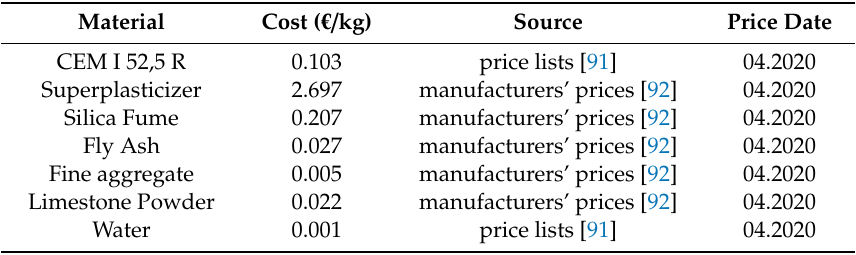
Table 10. Unit price of